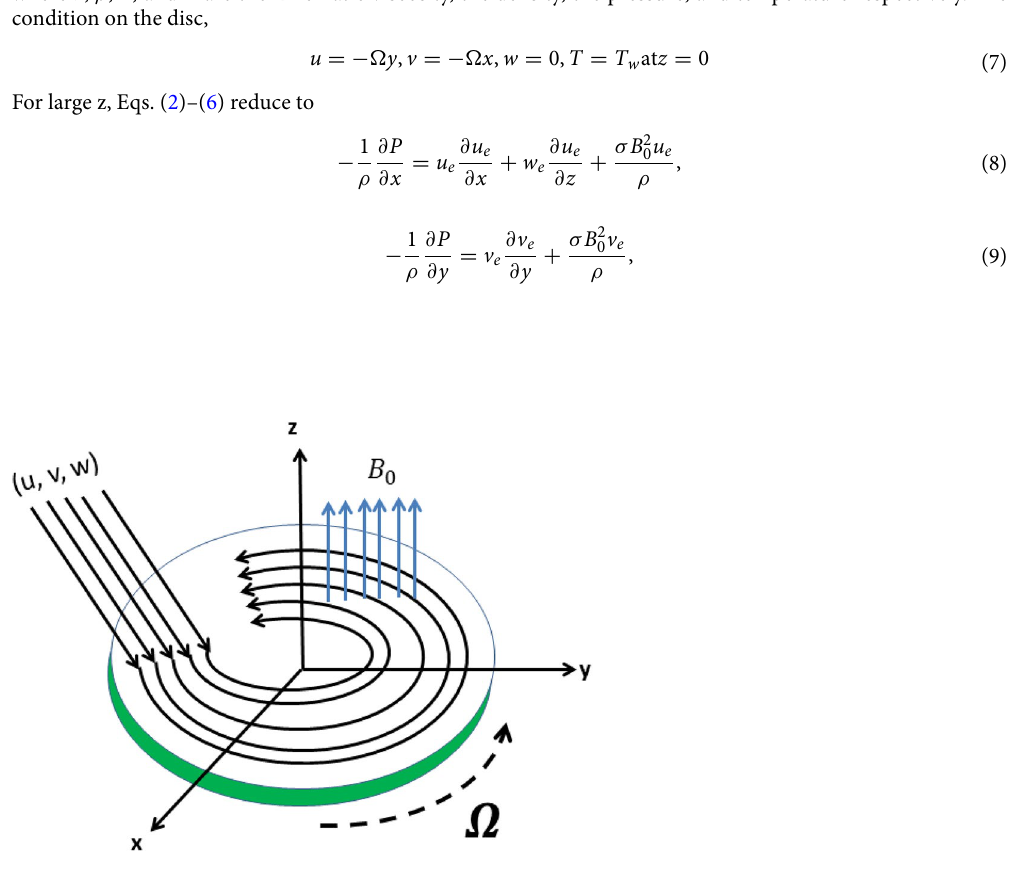
Figure 1. Problem’s